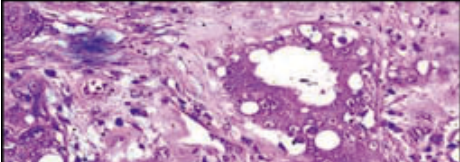
Fig.10. Cystic papillary carcinoma - papillae extended into marked dilated and cystic tubular lumina (H&Ex100)